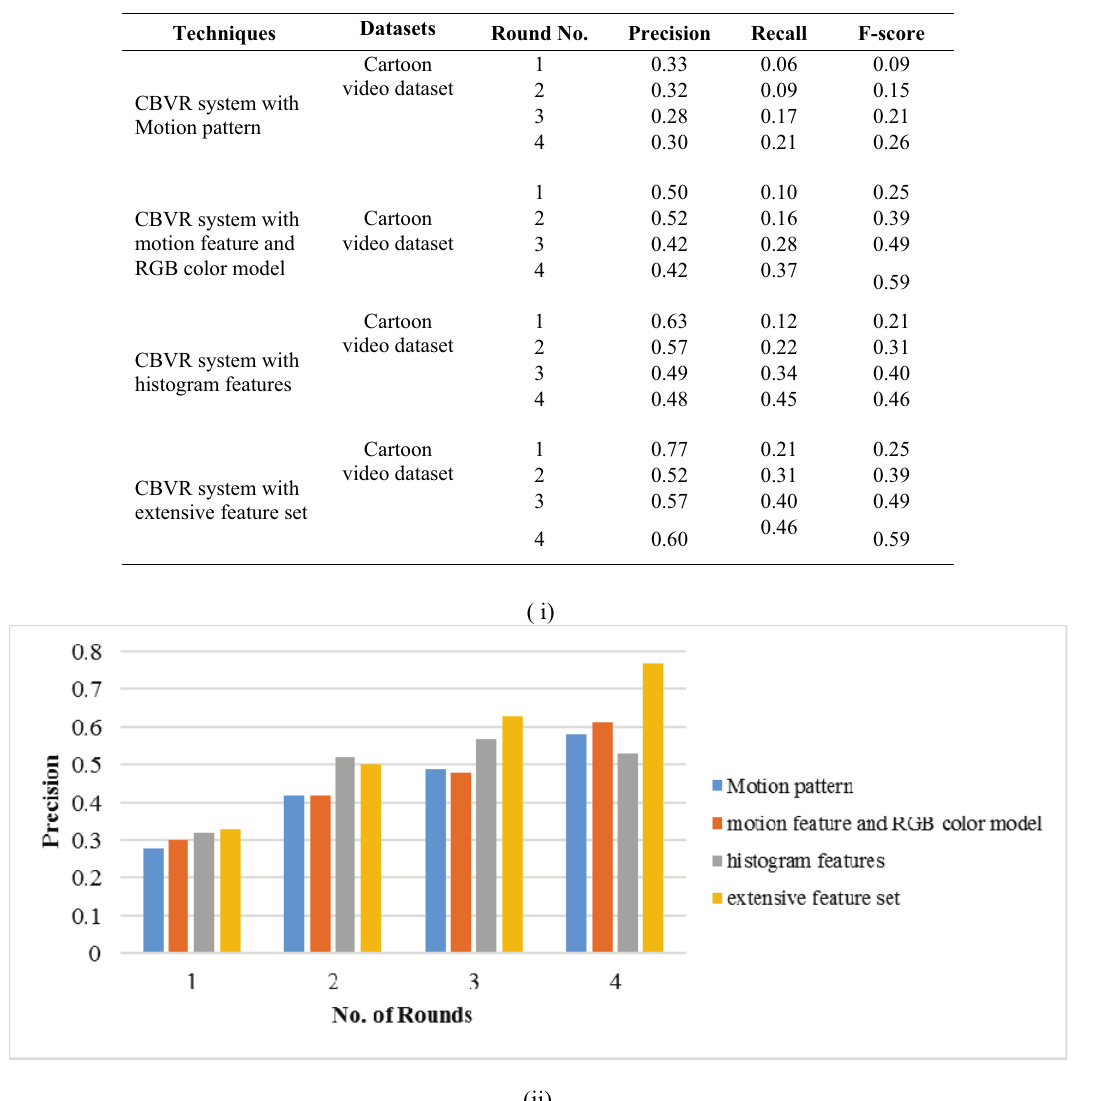
Table. 6. Comparison plot of Mean (i) Precision, (ii) recall and (iii) F-score values for different rounds of retrieval obtained by the proposed CBVR system and other existing systems with cartoon video